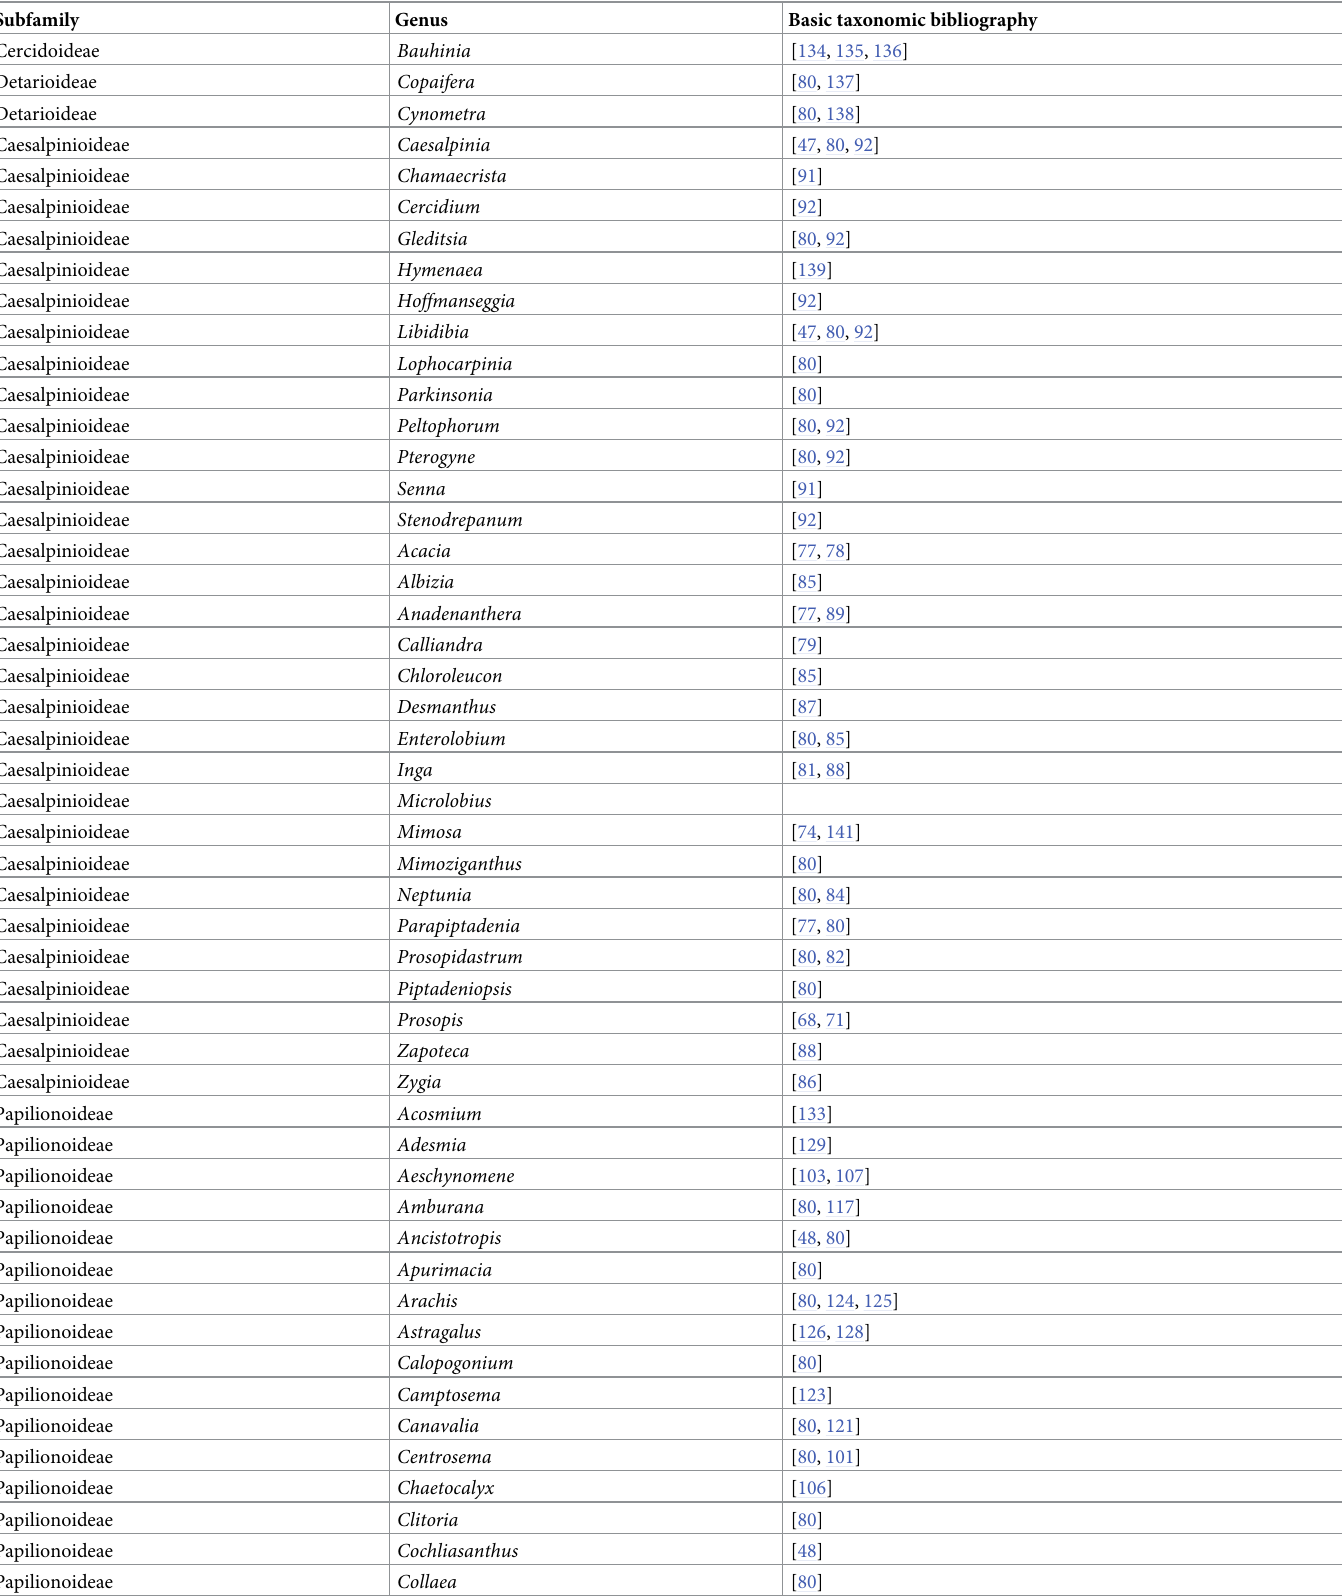
Table 1. Essential references for the taxonomic identification of Chaco Legumes.